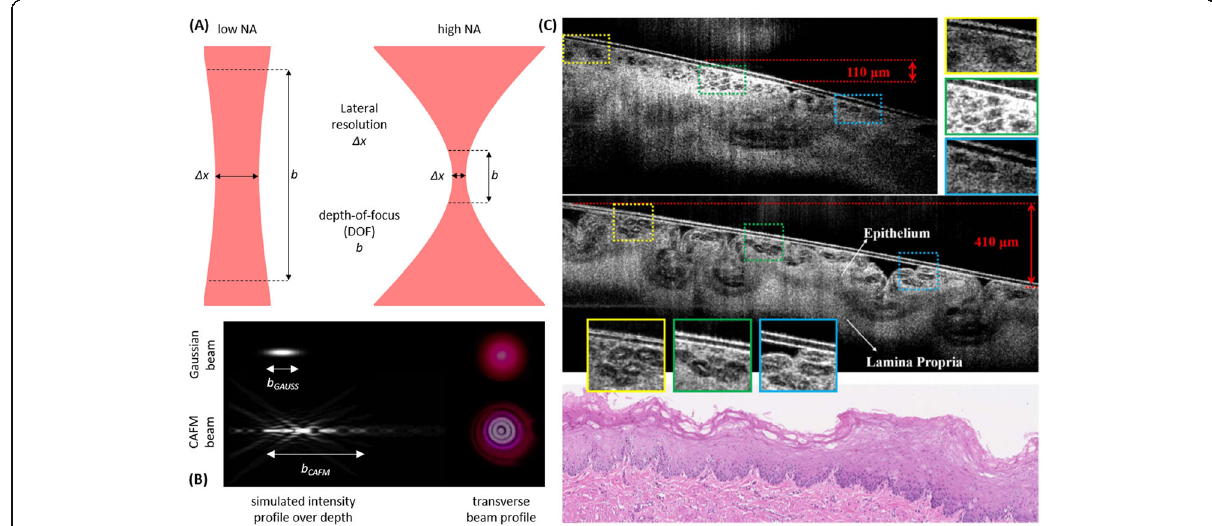
Fig. 9 Milestone 7: µOCT enables maintenance of high lateral imaging resolutions over an extended DOF. a low NA vs. high NA imaging with regards to lateral resolution ( Δ x ) and DOF ( b ). b DOF extension using coaxially focused multi-mode (CAFM) beam. Simulation results of the intensity profile over depth as well as real transverse beam profiles of both a Gaussian and a CAFM beam are depicted. c µOCT images of esophageal swine tissue ex vivo compared to those obtained by conventional probe optics (figure and caption adapted and reprinted with permission from [133] © The Optical Society